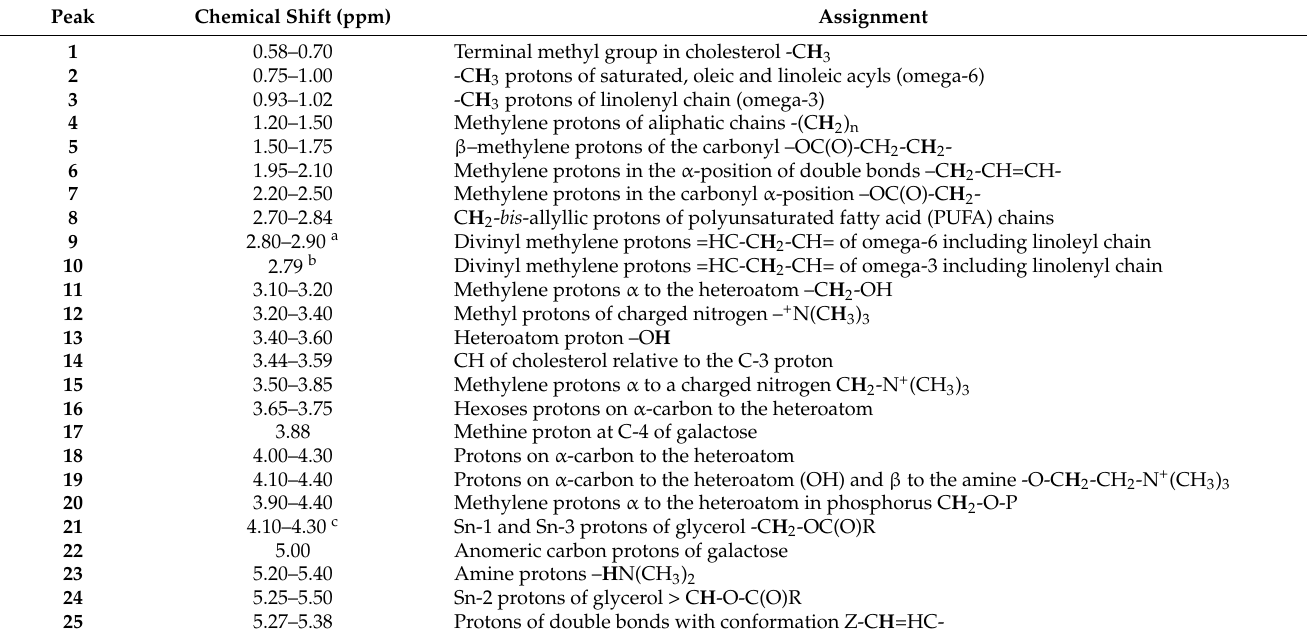
Table 1. Rat serum 1 H-NMR spectral assignments. The NMR peaks were numbered as illustrated in Figure S1 (Supplemen- tary Information). Legend: a omega-6, b omega-3, and c glycerol (see Equations (1) and (2) in Methods Section). Peak